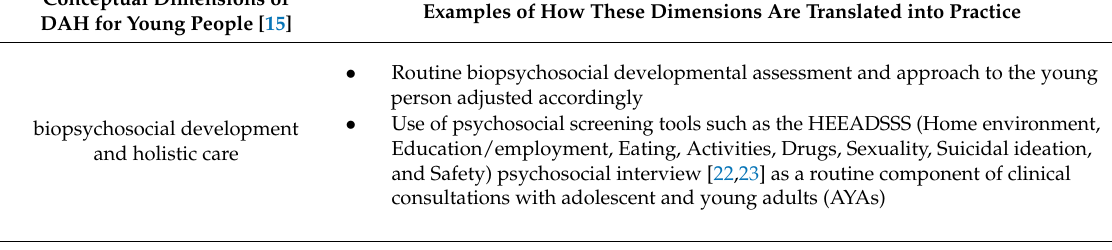
Table 2. Some examples of how the five conceptual dimensions of developmentally appropriate healthcare (DAH) for young people are translated into